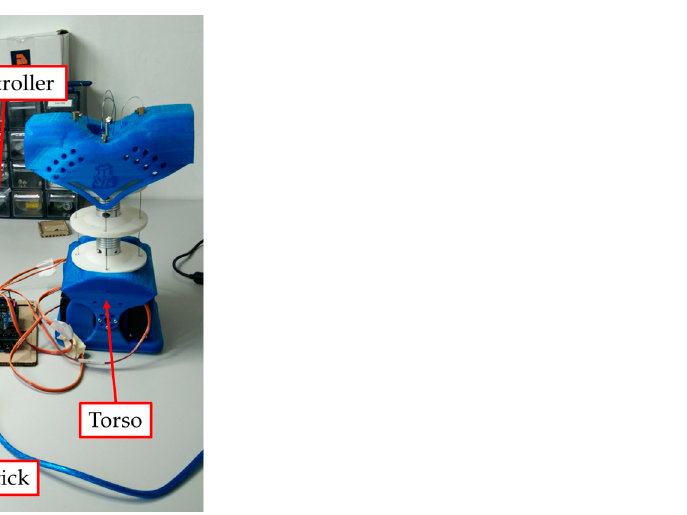
Figure 6. Motion control of the LARMbot’s torso mechanism through a joystick, with motion mapping to angle of direction and bending angle. F: forward; FL: forward-left; L: left; BL: backward-left; B: backward; BR: backward-right; R: right; FR: forward-right.